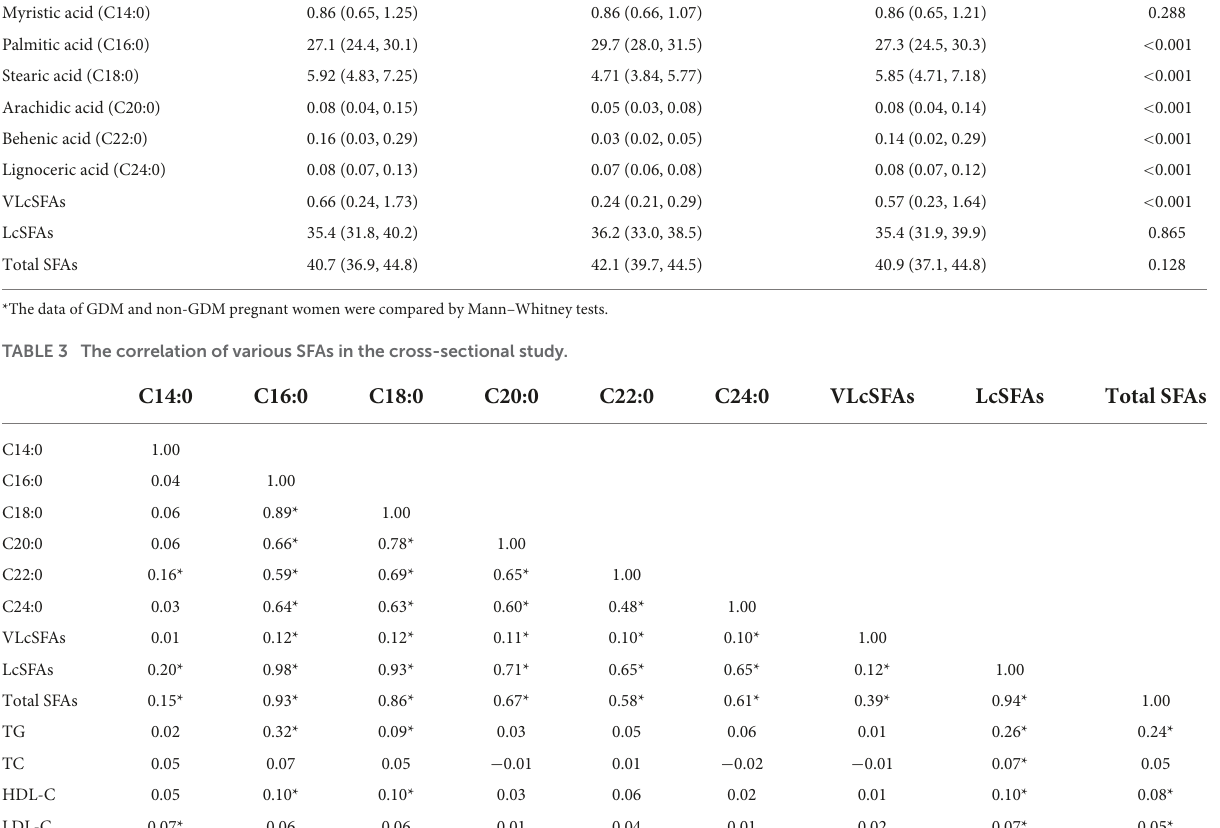
TABLE 2 Plasma SFAs (percentage, % of total fatty acids) in pregnant women with vs. without GDM in the second trimesters. Non-GDM GDM